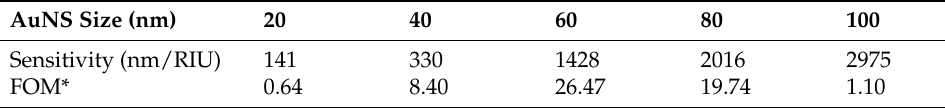
Table 2. FOM* of fiber sensors with different AuNS